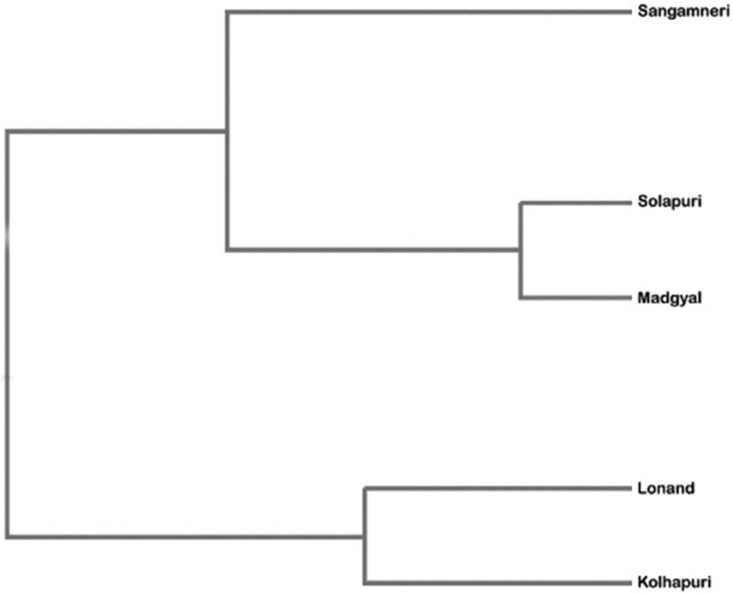
UPGMA based dendrogram using pair-wise Mahalanobis distances.